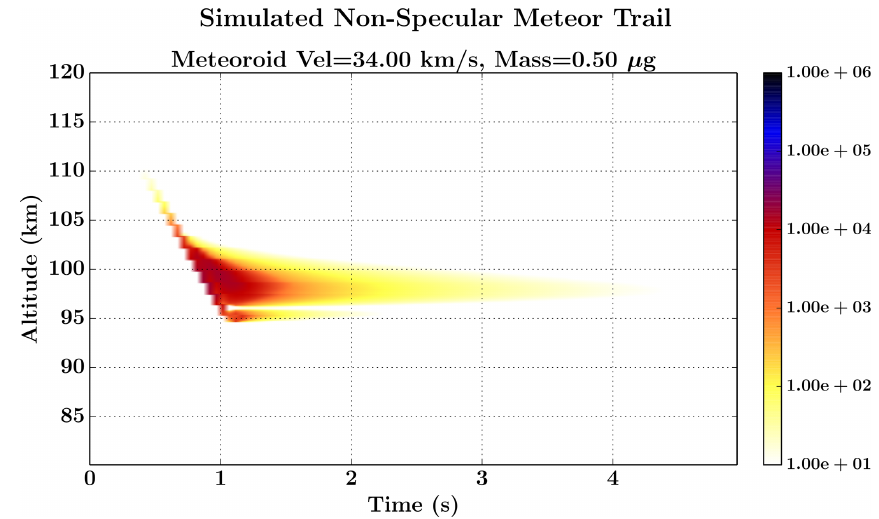
Figure 9. Simulation showing the effects of neutral wind shears, using a meteoroid with a mass of 0.5µg that is traveling at 34kms − 1 . The background atmosphere/ionosphere conditions have a vertical profile similar to those displayed in Fig.